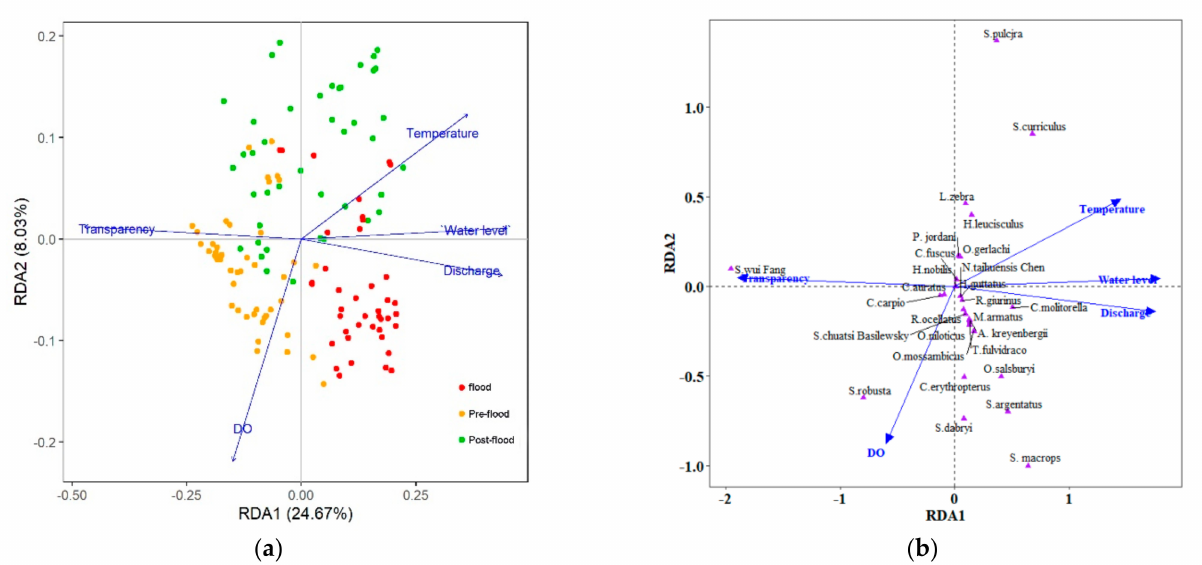
Figure 6. Biplot canonical RDA of environmental factors and samples ( a ), and biplot RDA of environmental factors and ichthyoplankton of the main fish species collected in the Laibin section of the Pearl River during the summer of 2017 ( b